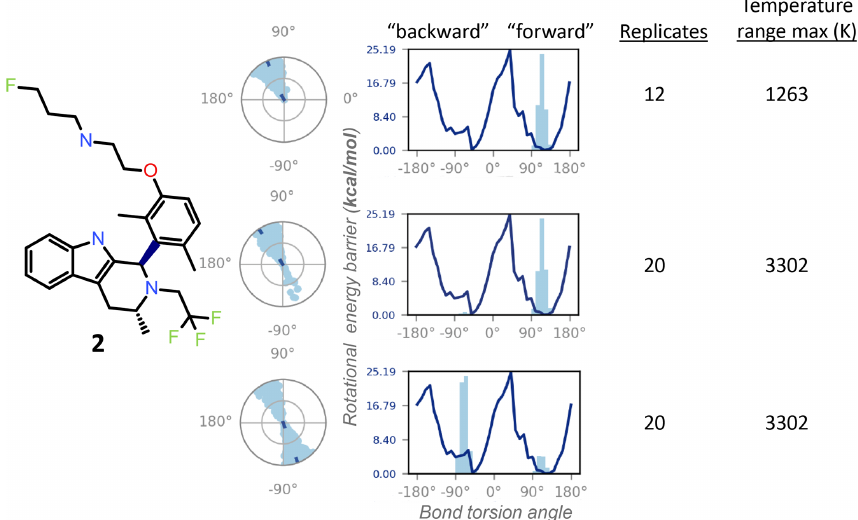
Figure 5. The REST-MD simulation of the dimethyl compound 2 predicts a preference to populate only one energy minimum, correlated with the initial dihedral angle starting condition in the simulation (dark dot in the center of the radial plots). Shown are results from calculations for conformations sampled as a function of bond rotation angle for the bond between the tricyclic core and the aromatic ring, bolded in the molecular structure. The three different simulation conditions are, from top to bottom: starting with the pendant base facing forward ( ∼+ 90 ◦ ) with a temperature range of 300–1263K (12 replicates); the same initial conformation, with a temperature range of 300–3302K (20 replicates); and the opposite initial conformation, with the pendant base facing backward, run with 20 replicates (300–3302K). All REST-MD simulations ran for